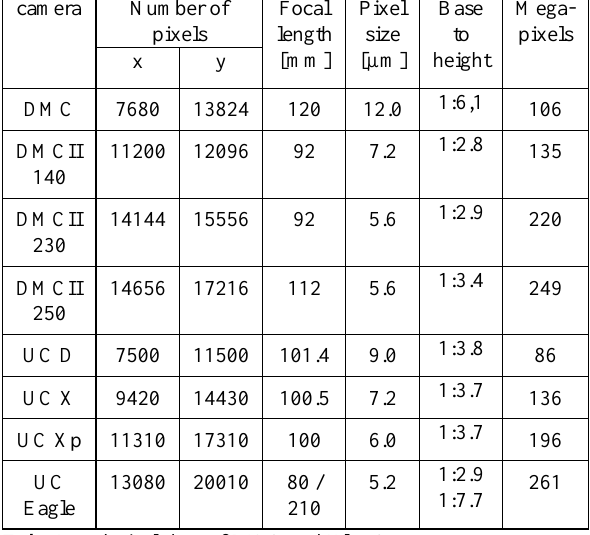
Tab. 1: technical data of DMC and UltraCam cameras The size of the stitched UltraCam images is approximately 68mm x 104mm for all versions.